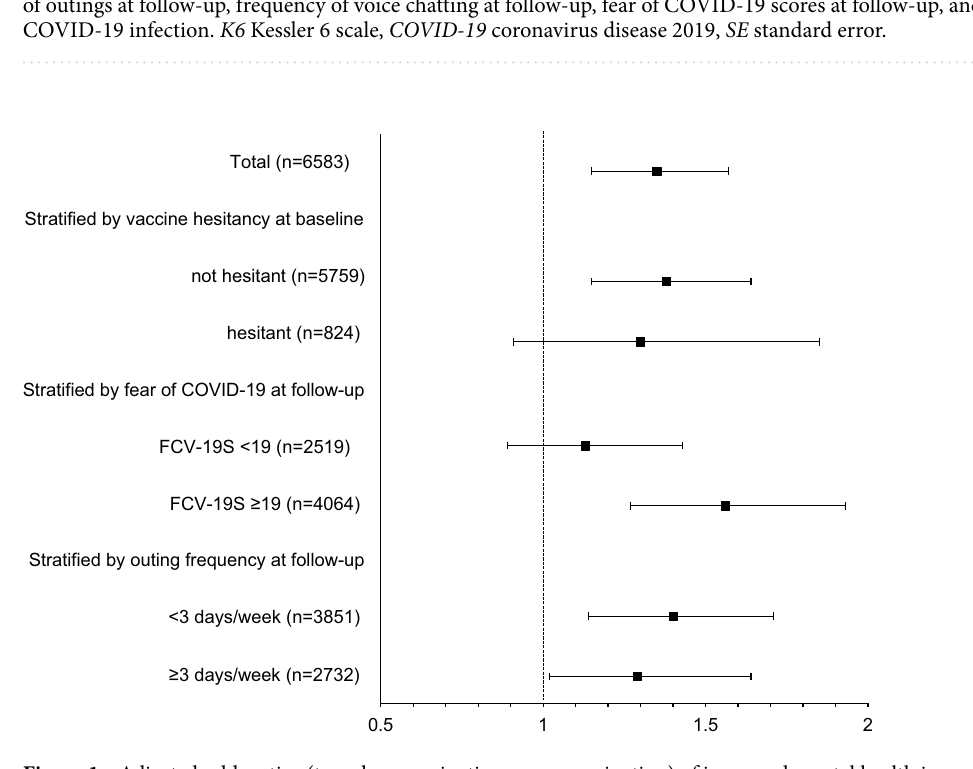
Figure 1. Adjusted odds ratios (two-dose vaccination vs. no vaccination) of improved mental health in participants with psychological distress at baseline, 2021, JACSIS,